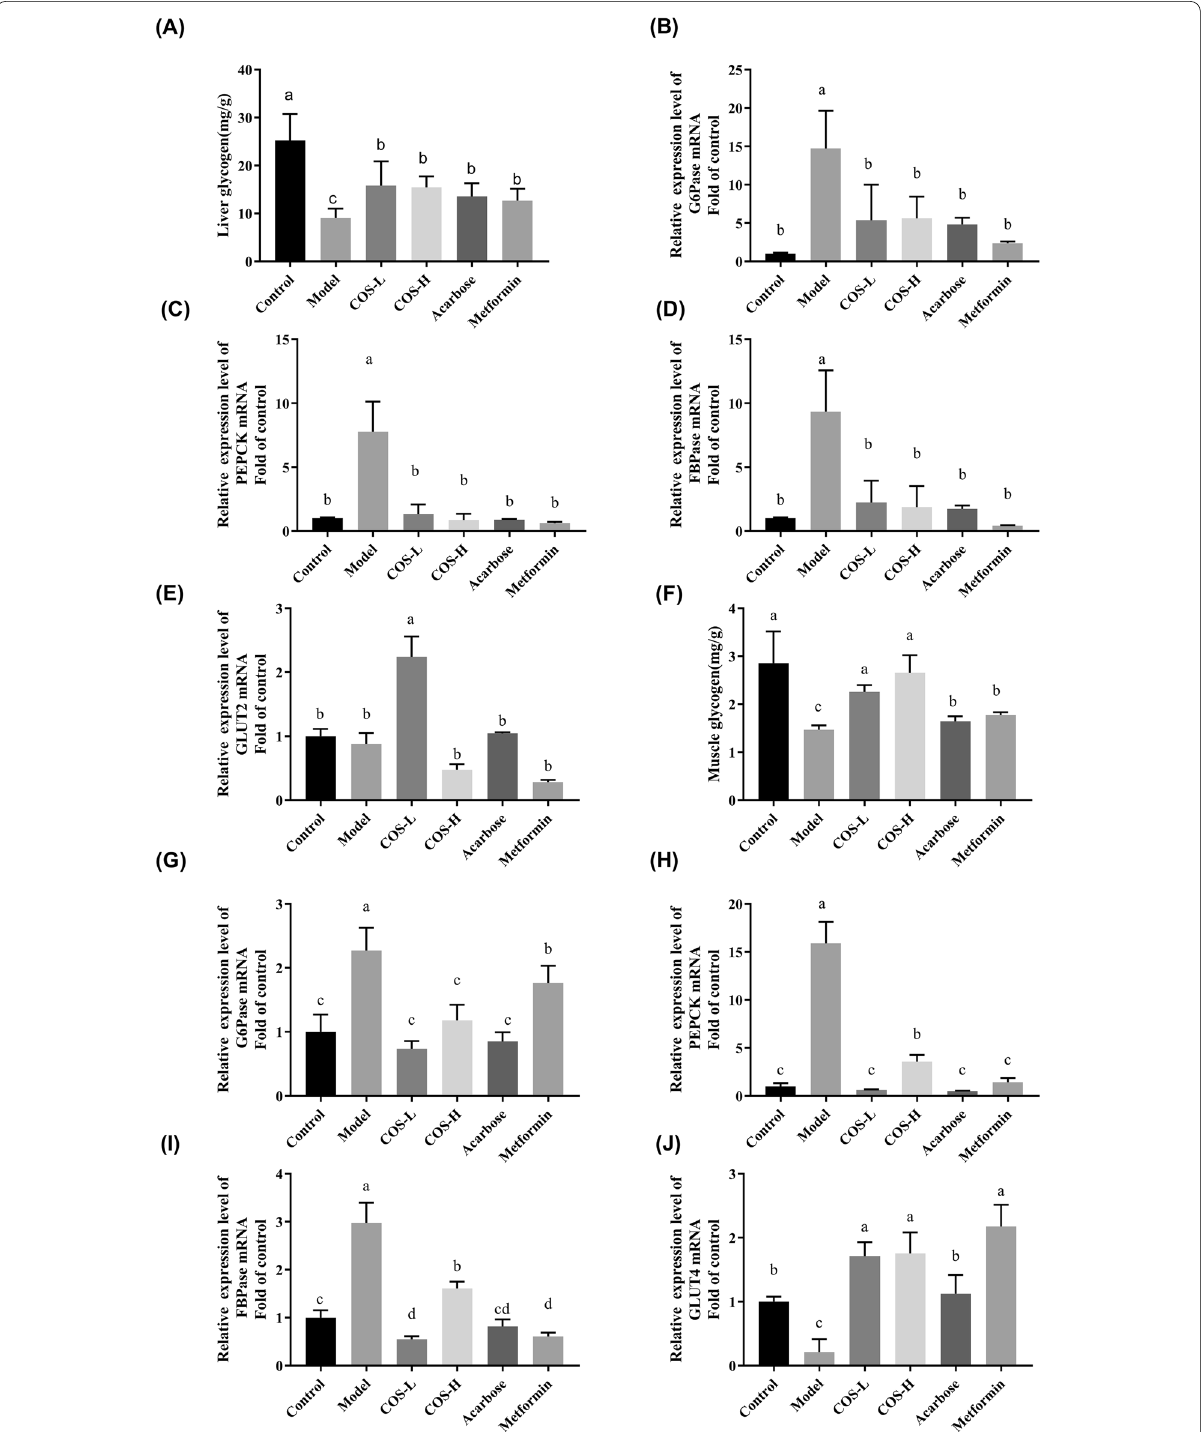
Fig. 9 The effect of COS on the mRNA expression of the glucose metabolism indexes in the mice. A Glycogen content in the liver, B liver G6Pase, C liver PEPCK, D liver FBPase, E liver GLUT2, F glycogen content in the skeletal muscles, G muscle G6Pase, H muscle PEPCK, I muscle FBPase, J muscle